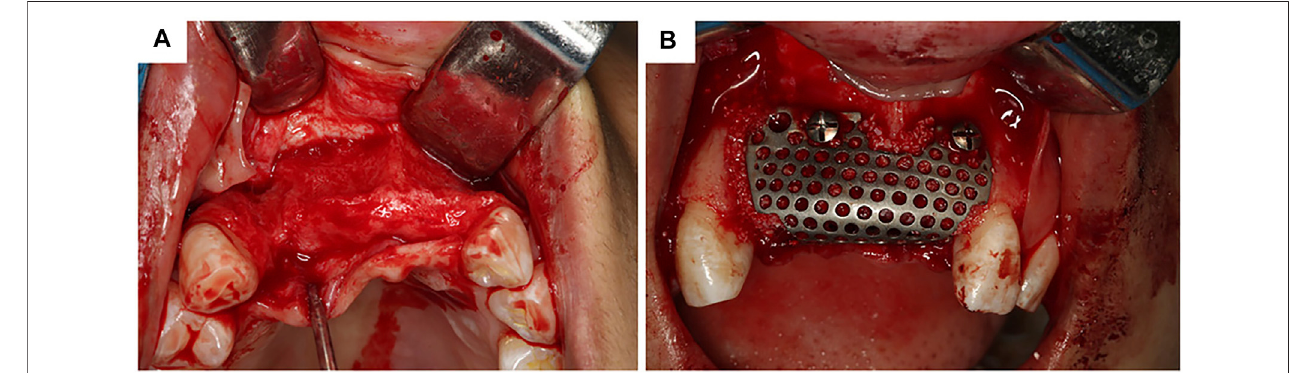
FIGURE 4 | Customized titanium mesh in clinical usage. (A) Exposure of alveolar bone ridge. (B) Fixation of customized titanium mesh.